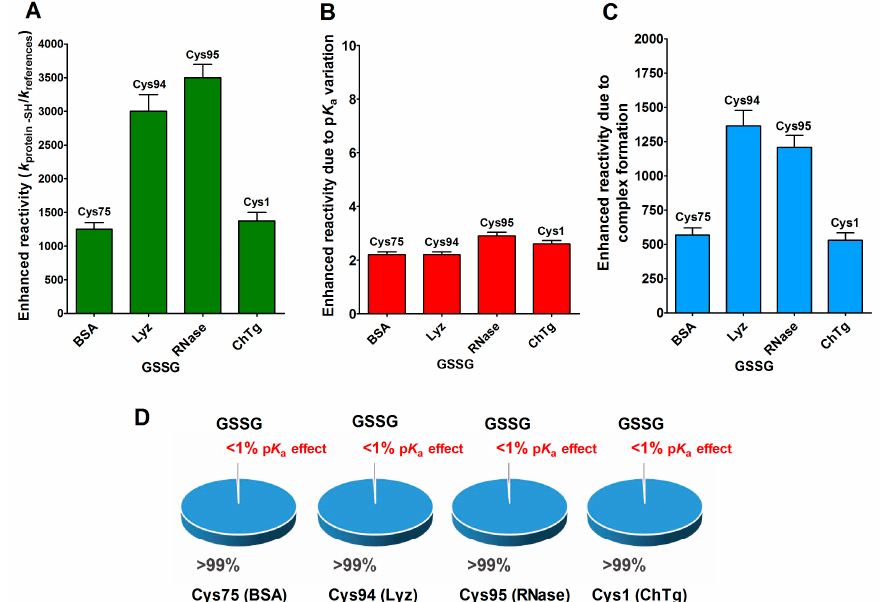
Figure 6. p K a and hydrophobic effects on the observed hyper-reactivity toward GSSG in different proteins. ( A ) Experimental kinetic data for the reaction of Cys75 for rBSA, Cys94 for rLyz, Cys95 for rRNase and Cys1 for rChTg with GSSG normalized to those of an unperturbed protein cysteine (enhanced reactivity) [13–16]. ( B ) Enhanced reactivity due to the experimental lower p K a of the protein cysteines of panel ( A ) (p K a values: 6.6 for Cys75, 6.6 for Cys94, 7.9 for Cys95 and 8.1 for Cys1) [13–16]. ( C ) Enhanced reactivity due to a transient complex. ( D ) Circle diagrams show the percent contribution of the two factors: transient complex protein-GSSG (blue) and p K a effect (red). The 100% represents the sum of the values reported in panel ( B ) and ( C ). The error bars in panels ( A – C ) derived from the propagation of uncertainties (see Section 4).